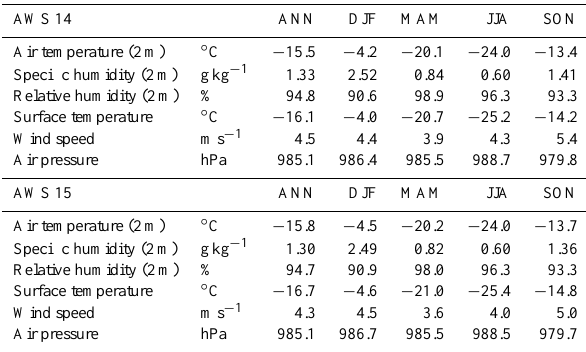
Table 1. Means of meteorological variables 1 February 2009– 31 January 2011 (28 January 2011 for AWS 15). ANN = average over all